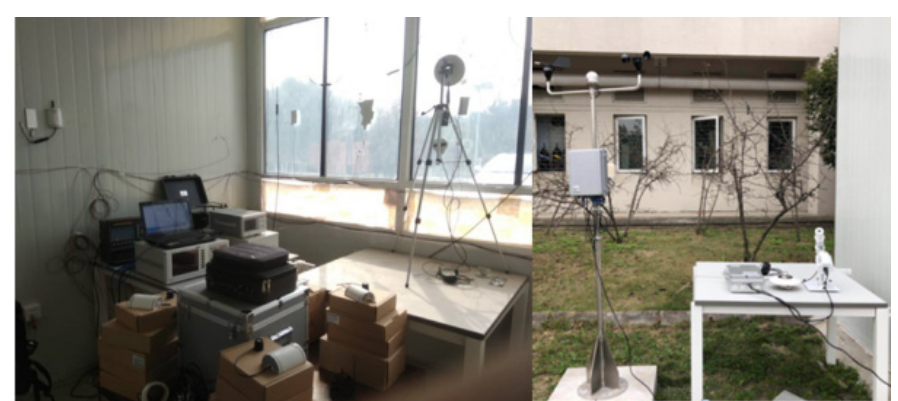
Figure 4. Schematic diagram of the indoor environment test instruments.